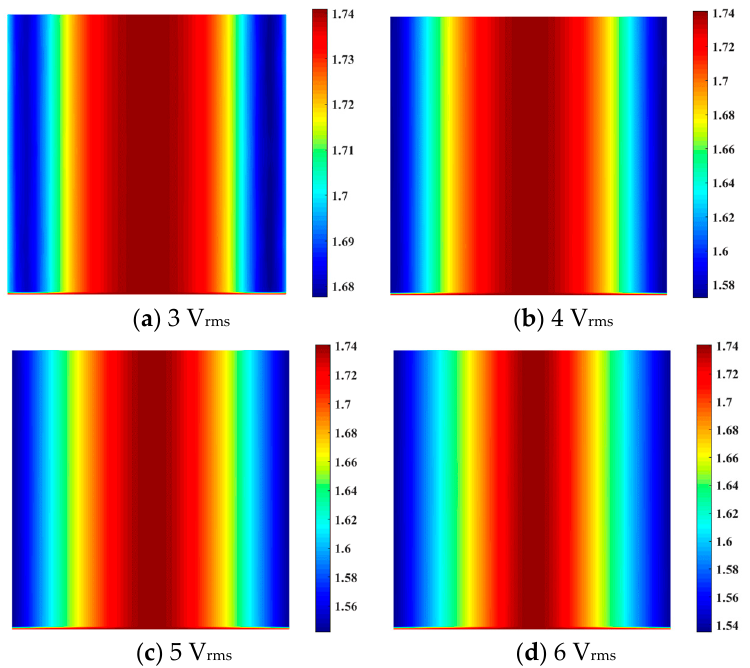
Figure 5. Simulated top view of the refractive index distribution across the LC microlens along the x axis for the extraordinary ray with different operating voltages.